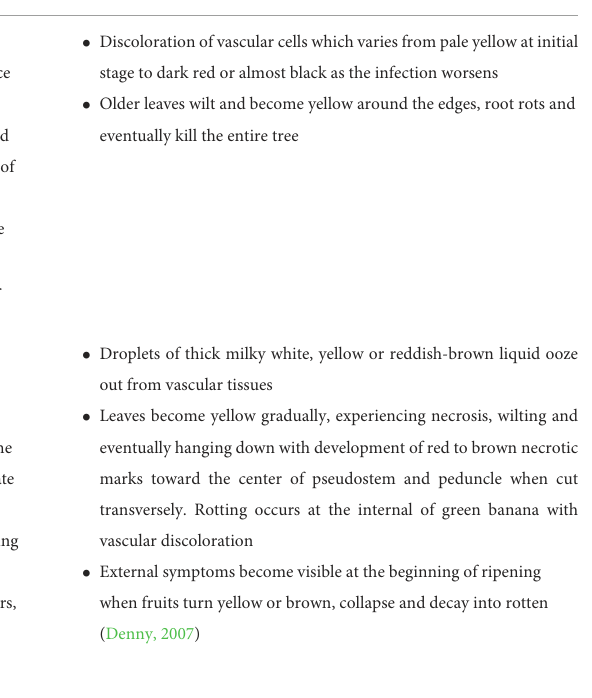
TABLE 3 A summary of major diseases affecting banana plantation.